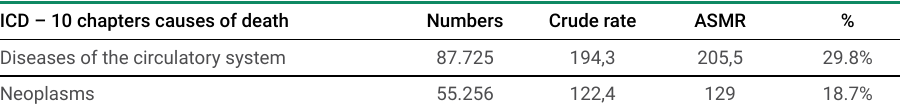
Table 1. Causes of death in Sao Paulo State according to ICD - 10 chapters. ICD – 10 chapters causes of